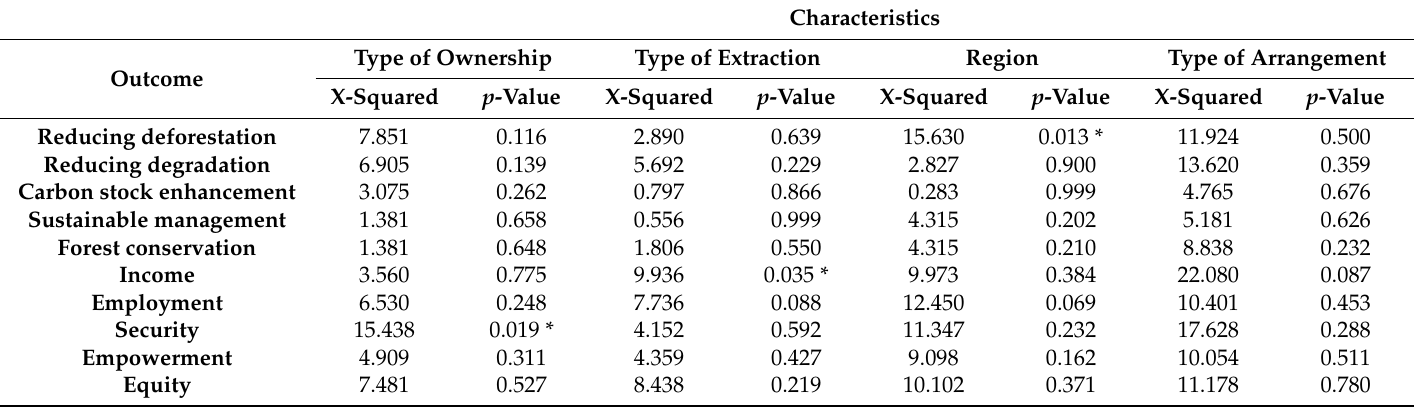
Table 3. Pearson’s Chi-squared test with simulated p-value between the assessed outcomes and four CFM characteristics. The null hypothesis for each test is of independence between the two nominal